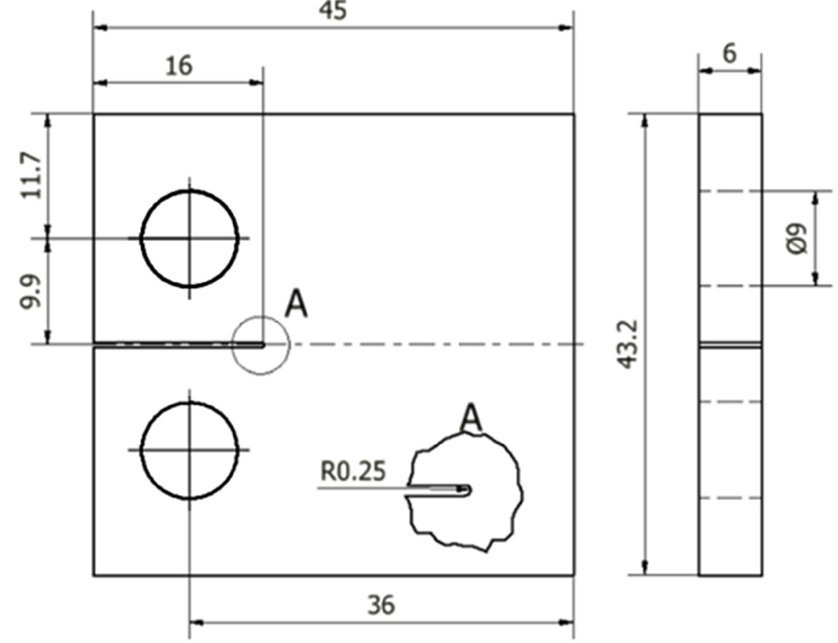
Figure 2. Specimen geometry (mm).